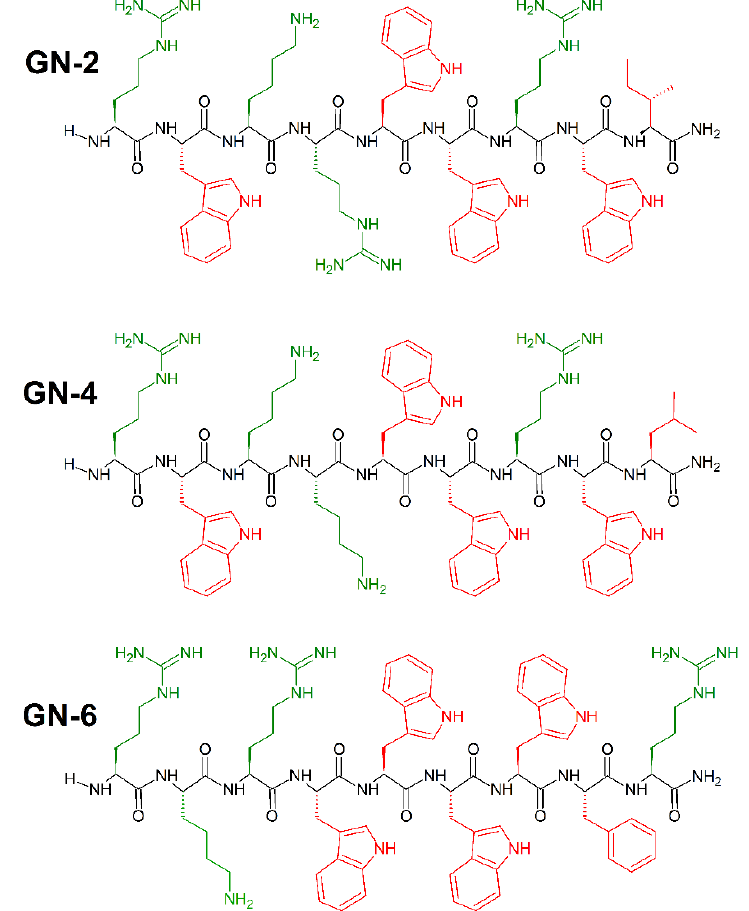
Figure 20. Chemical structures of GN-2, GN-4 and GN-6 peptides. In green: positively charged amino acids; in red: hydrophobic amino acids.